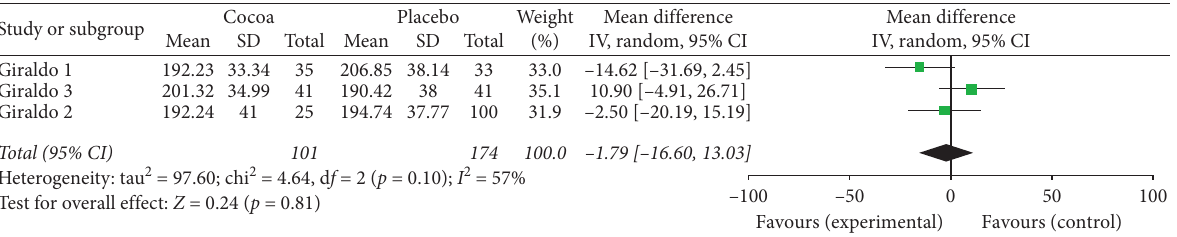
Figure 2: Meta-analysis of the effect of cocoa consumption on total cholesterol (TC) as compared with placebo. The sizes of the data markers indicate the weight of each study in the analysis. IV: inverse variance.